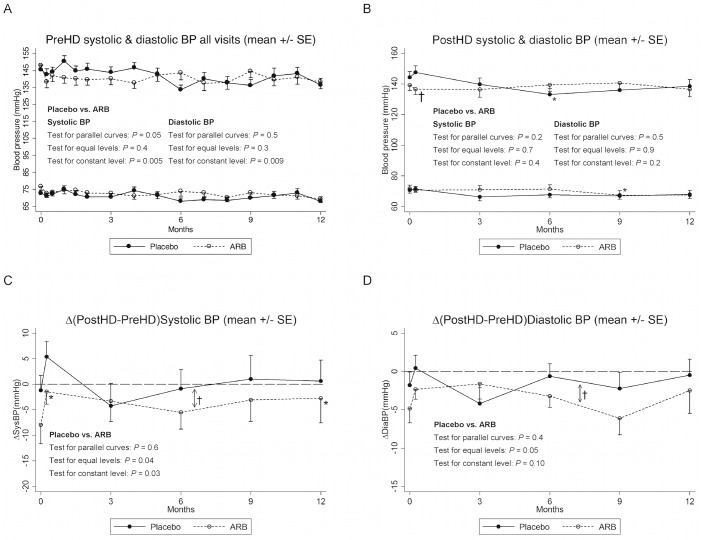
Pre- and postdialytic blood pressures.Fig 2A-B is reused from our previous publication but is slightly modified compared to the original. Image reproduced under a CC-BY licence from [26] with permission from Nature Publishing group. PreHD: Predialytic blood pressure (BP); PostHD: Postdialytic BP; Δ: PostHD-PreHD difference; *) 0.05>P≥0.01 vs. baseline within the placebo or ARB group; †) 0.05>P ≥0.01 placebo vs. ARB; ↕†) in Figs 2C-D indicates that parallel curves were assumed (Model 2). The constant mean differences (placebo-ARB) with 95% confidence interval were 6.2(0.5–11)mmHg; P = 0.03 (Δ(PostHD-PreHD)Systolic BP) and 3.0(0.1–6.0)mmHg; P = 0.04 (Δ(PostHD-PreHD)Diastolic BP). Note that Fig 2A shows all predialytic BP values recorded between baseline and 12 months, whereas the P-values given in 2A were based on values obtained at baseline, 1 week, 3 months, 6 months, 9 months, and 12 months, respectively from multivariate repeated meaurements analysis (xtmixed). Mean values from these time points are given in Table 2.